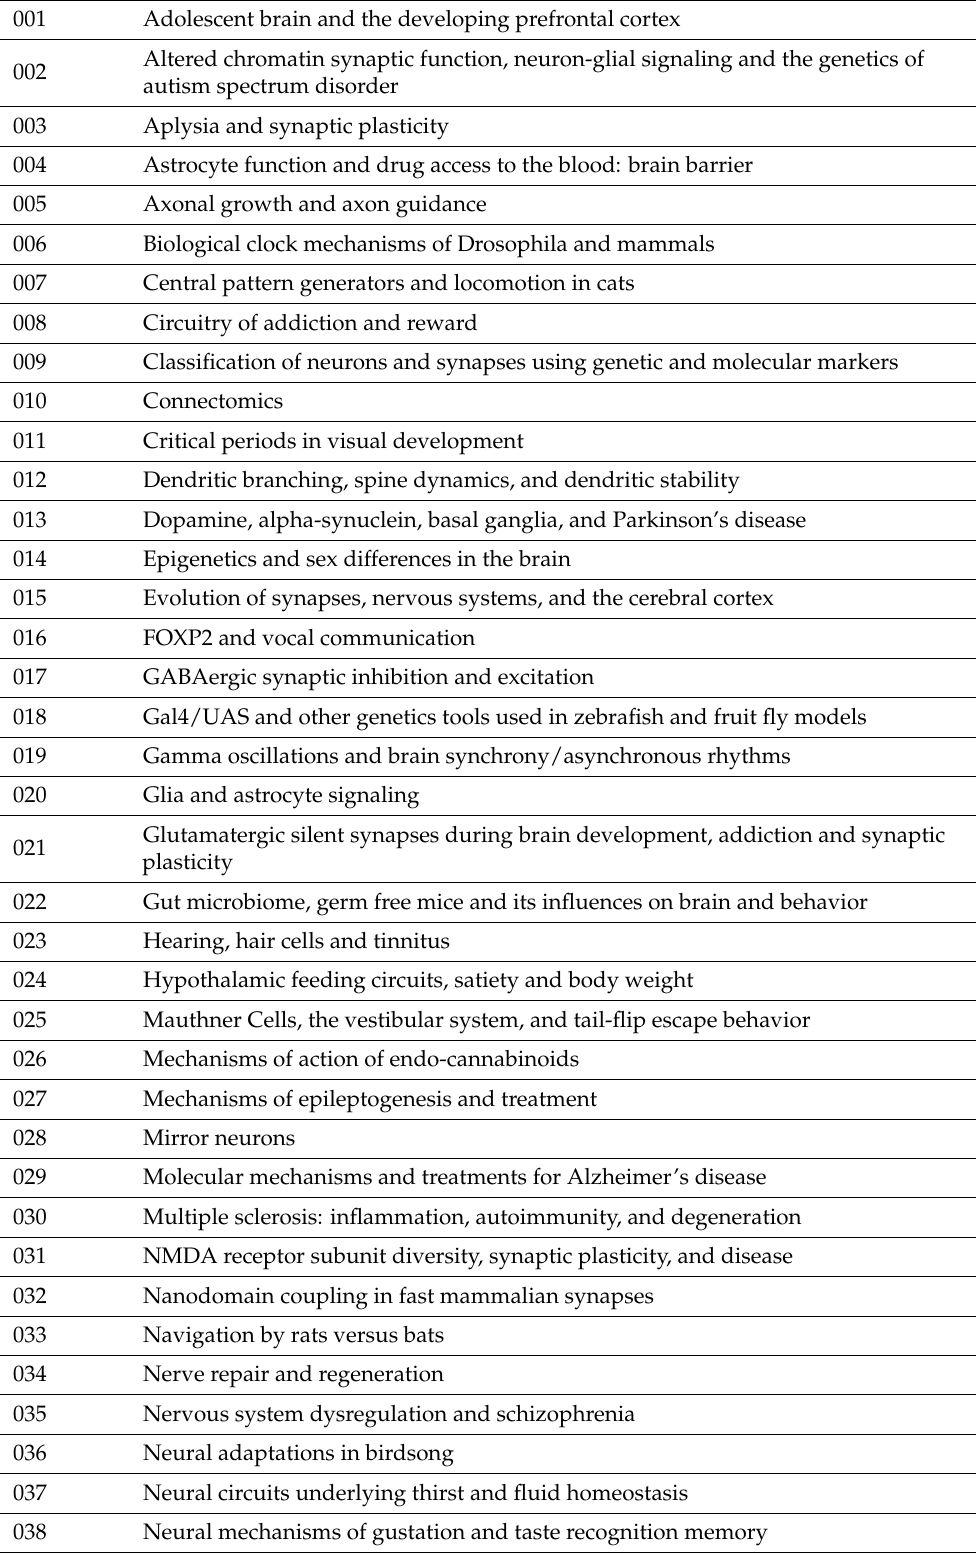
Table A1. Available research topics (001 to